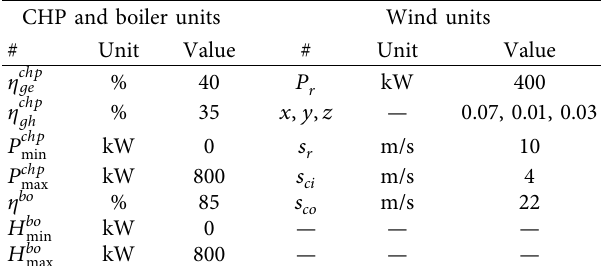
Table 4: Technical information of the local units. CHP and boiler units